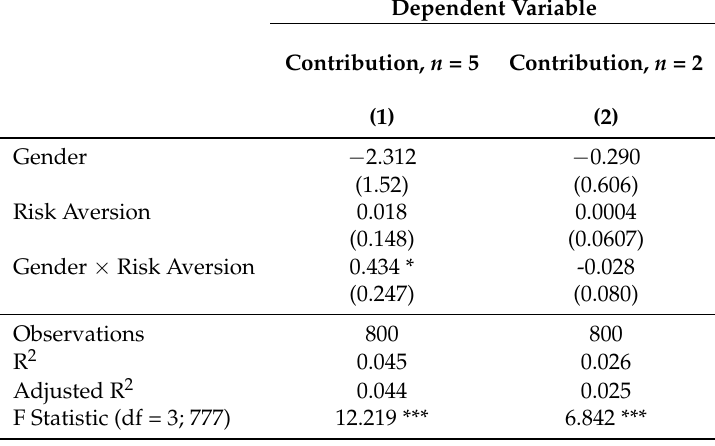
Table 7. Contributions to the joint product explained by gender and risk aversion. Groups size n = 5, SCF with complementarities. Standard errors (in parenthesis) clustered on group and individual.